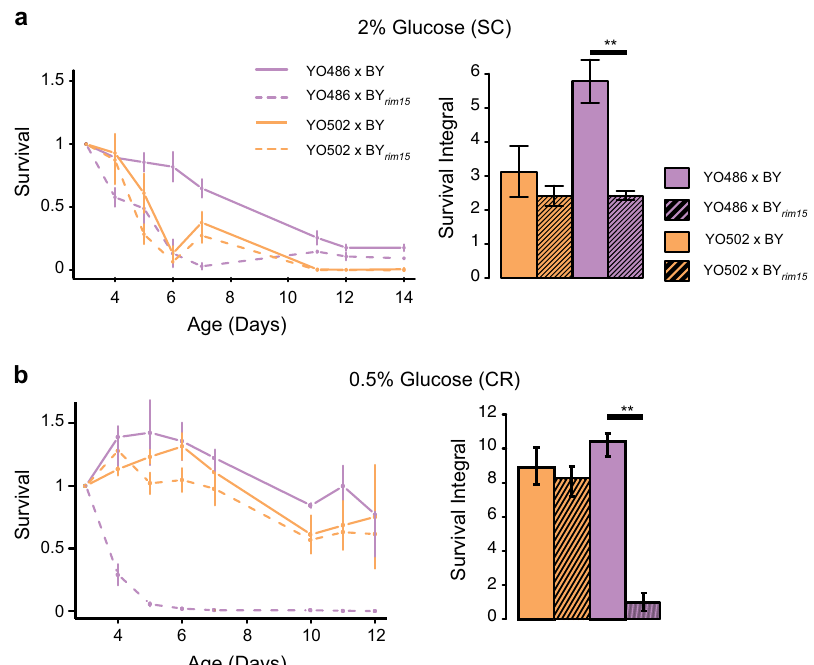
Fig. 4 Validation of RIM15 as an aging gene by a non-complementation approach. Survival curves and survival integrals were determined using an outgrowth kinetics assay for the indicated hybrid strains in SC medium containing 2% glucose ( a ) and 0.5% glucose (calorie restriction) ( b ). The results correspond to mean ± SDs for three biological replicates. Double asterisk, signi fi cantly different from control strain by Student ’ s t -test, p -value <